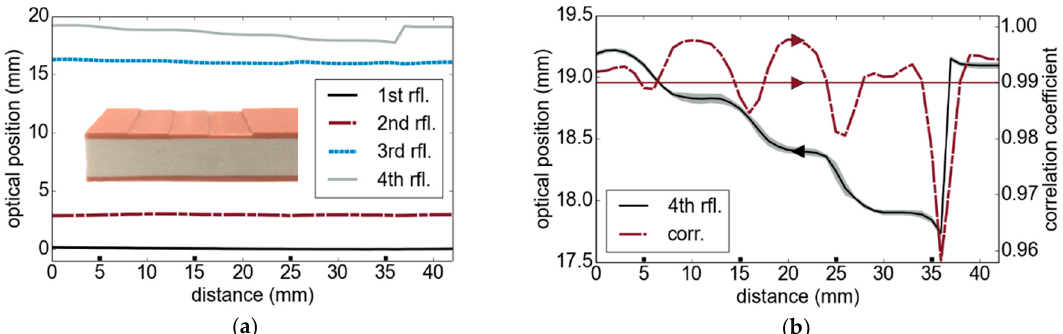
Figure 6 . Multilayer tube section: ( a ) optical positions ( path length difference) of reflectors, (inset) photograph of the stepped multilayer section; ( b ) increased depiction of the stepped layer and the corresponding correlation coefficient (corr.) which is related to the right y -axis; the squares along the x -axis indicate the step positions . rfl., reflection.